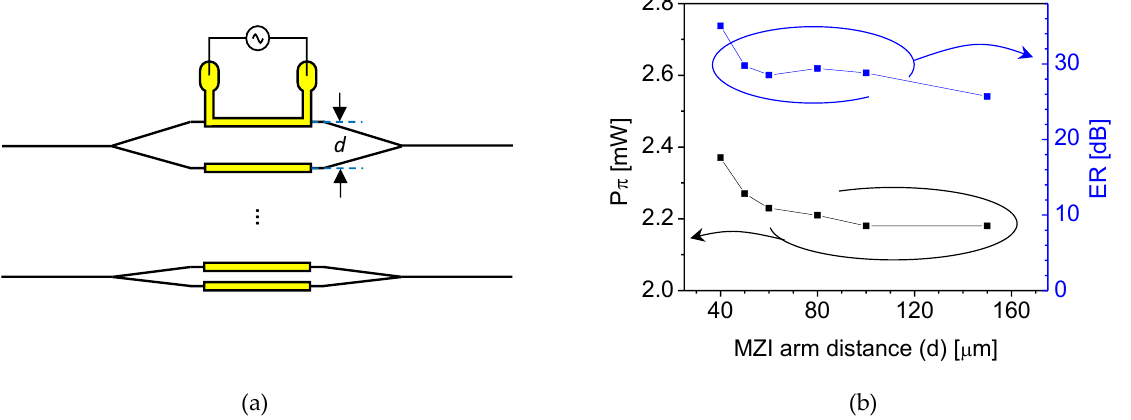
Figure 12. ( a ) Schematic diagram of the MZI array with different arm distances. ( b ) Measured P and extinction ratios (ER) of the phase modulators with 10- μ m wide 3 mm long microheaters.